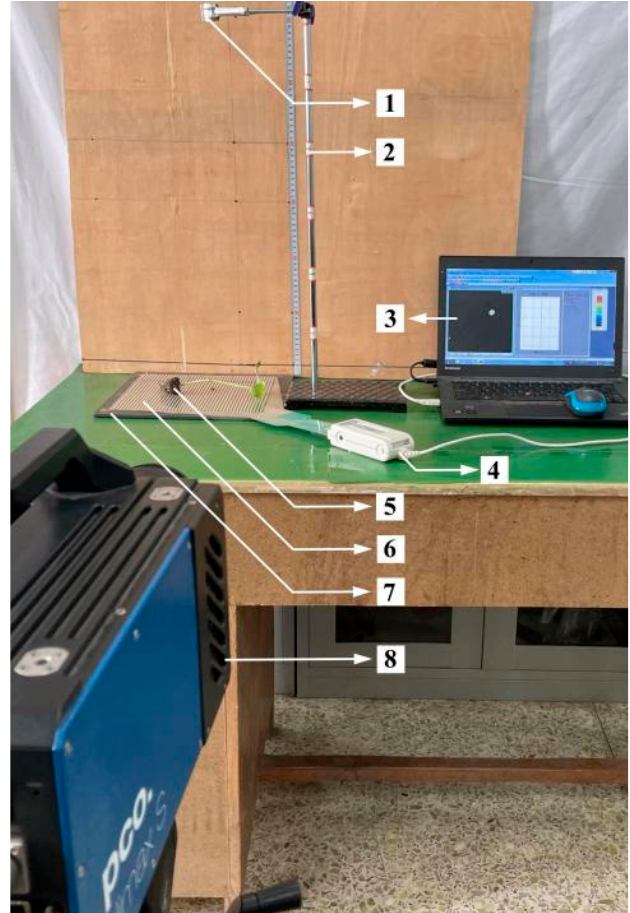
Figure 2. Seedling impact test system: 1. gripper; 2. bracket; 3. computer; 4. data acquisition and device; 5. oil sunflower plug seedlings; 6. Tekscan 5250-type tactile pressure sensor; 7. collision material; 8. high-speed digital camera.